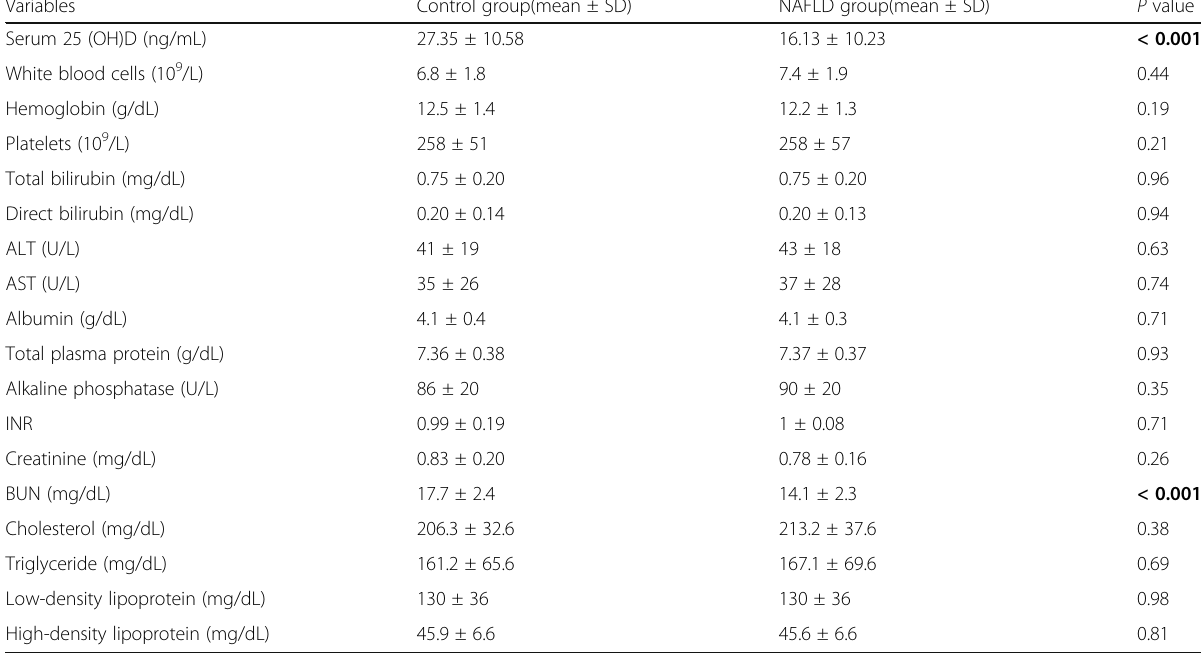
Table 2 Laboratory investigations of the two study groups at baseline